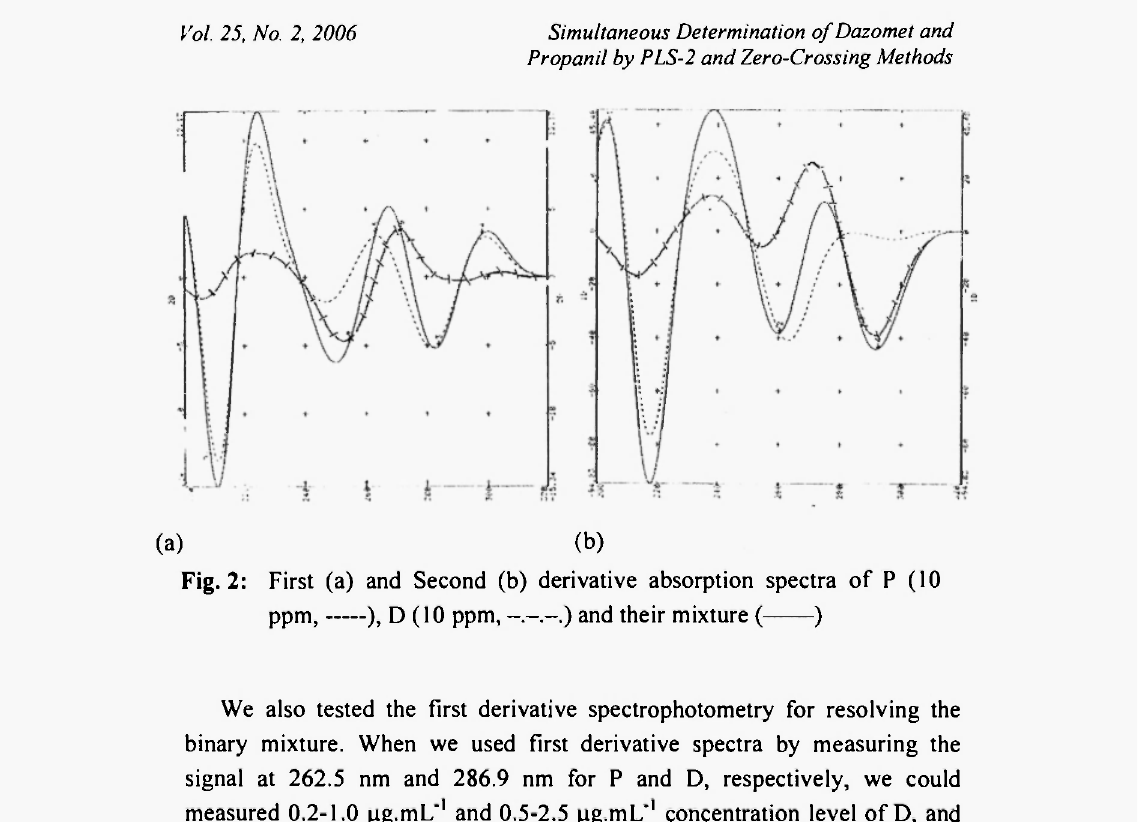
We also tested the first derivative spectrophotometry for resolving the binary mixture. When we used first derivative spectra by measuring the signal at 262.5 nm and 286.9 nm for Ρ and D, respectively, we could measured 0.2-1.0 μg.mL" l and 0.5-2.5 μg.mL' l concentration level of D, and P, respectively. Table 3 presents the results of the analyses of different